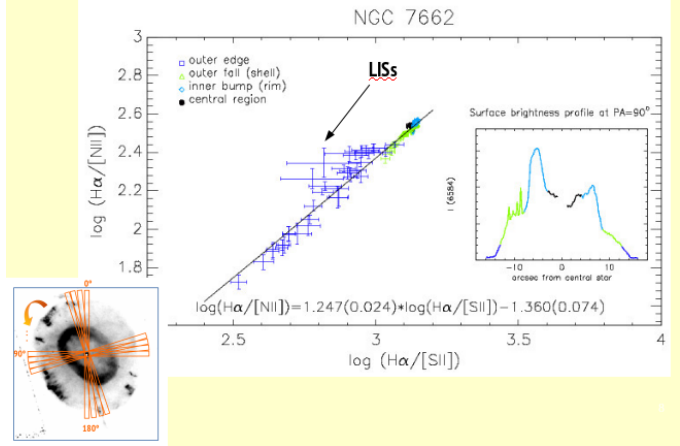
Figure 2. The E2DD derived from sectors of NGC 7662. The bottom-left insert illustrates the method how sectors are arranged in investigating the nebula. Different colors are related to different sectors within the nebula. The right inner plot shows (as an example) the extracted [N II ] brightness profile at PA = 90 ◦ showing the main fragmentation structures.